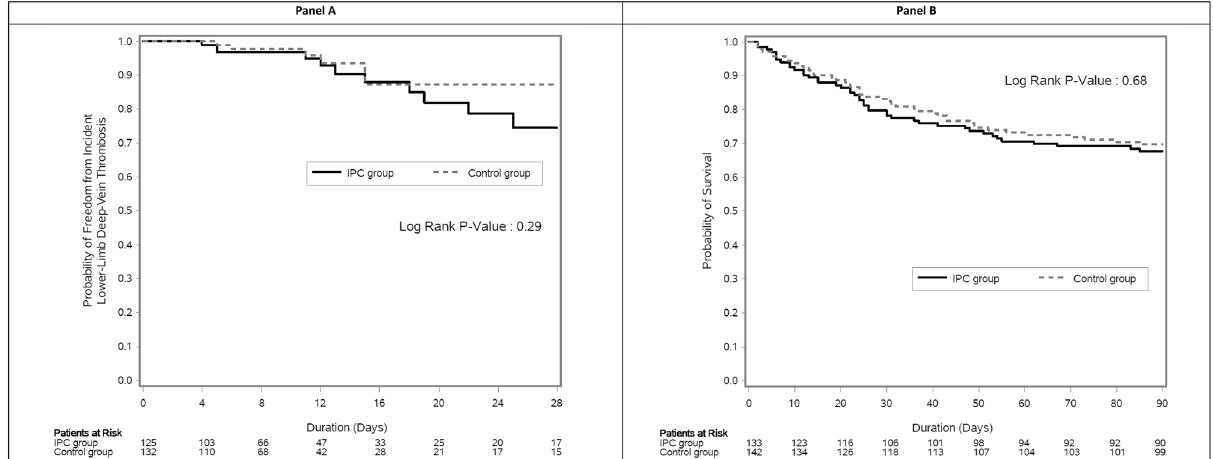
Figure 1. Kaplan–Meier curves for the freedom from incident lower-limb deep-vein thrombosis within 28 days (Panel A ) and for 90-day survival (Panel B ) in patients with HF randomized to receive intermittent pneumatic compression with pharmacologic thromboprophylaxis (IPC group) or pharmacologic thromboprophylaxis alone (control group). The log rank test was used to compare the two